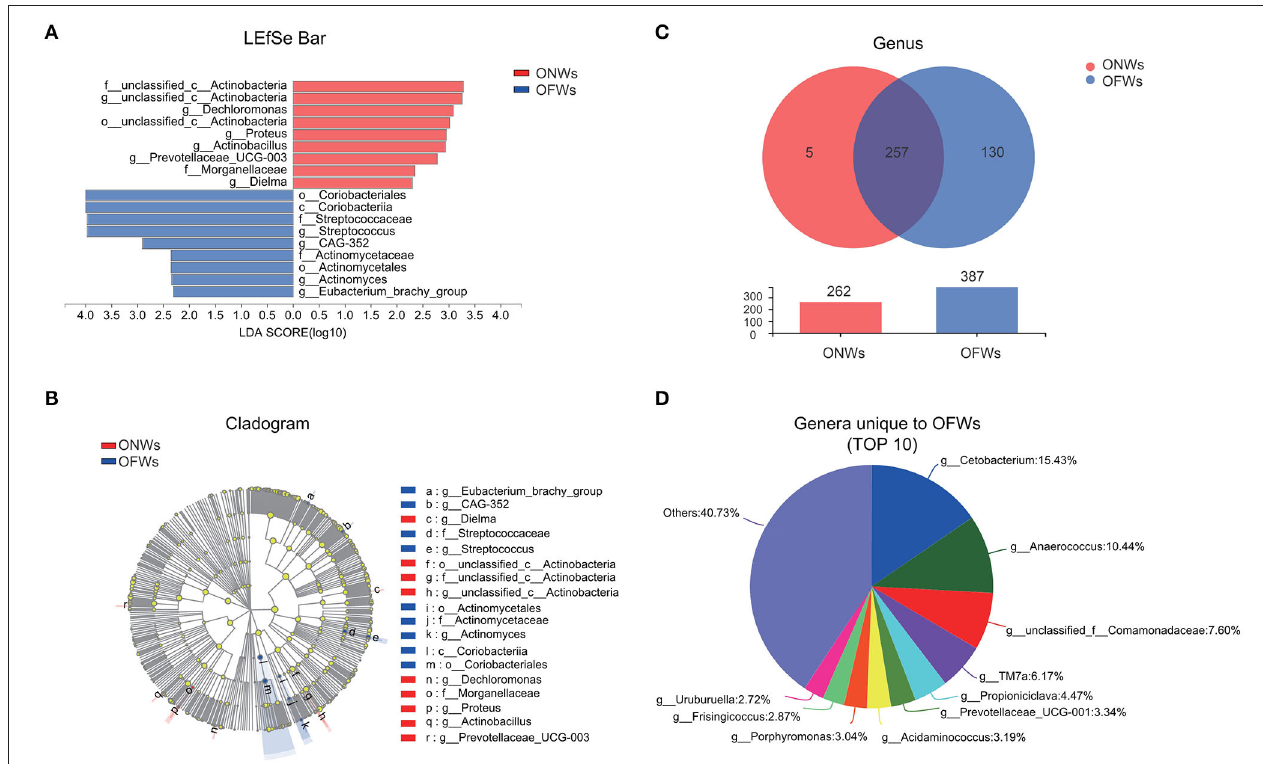
FIGURE 2 | The microbiota profile differs between ONWs and OFWs. (A) Histogram of the linear discriminant analysis (LDA) scores for differentially abundant taxonomic features between ONWs and OFWs. (B) Cladogram of the microbial taxa associated with ONWs and OFWs. Significance obtained by LDA score > 2. (C) The Venn diagram compares and contrasts the number of taxa at genus levels of ONWs and OFWs. (D) The top 10 genera are unique to OFWs. ONWs, onshore workers; OFWs, offshore workers.